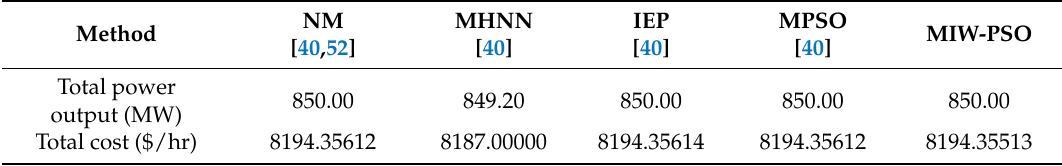
Table 3. Simulation result comparison on the first case study.